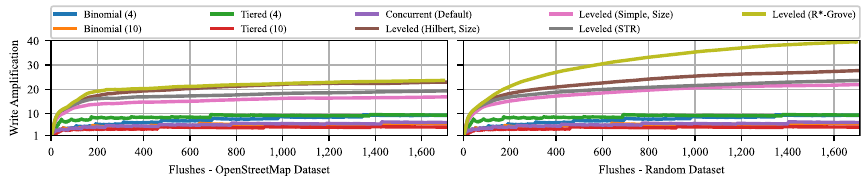
Fig. 8 Write amplification of compared policies with different configurations